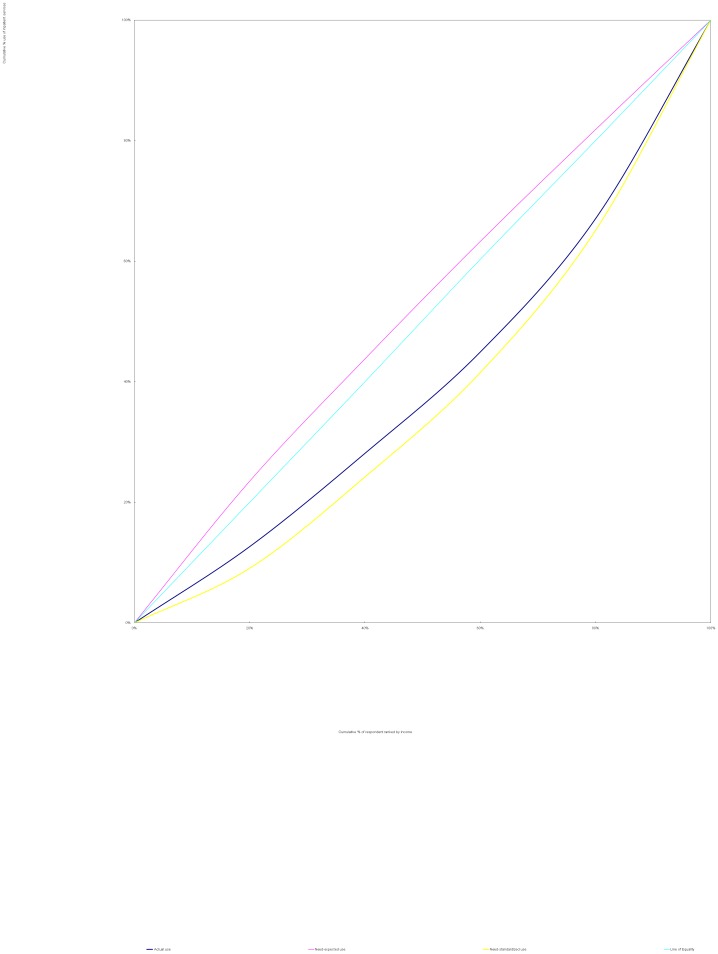
Concentration curves for use of inpatient services, China 2008.The line of need-expected services lie above the equality line. Both lines of actual use and of need-standardized services lie below the equality line. The line of need-standardized services lie farther away from the equality line than that of actual use.